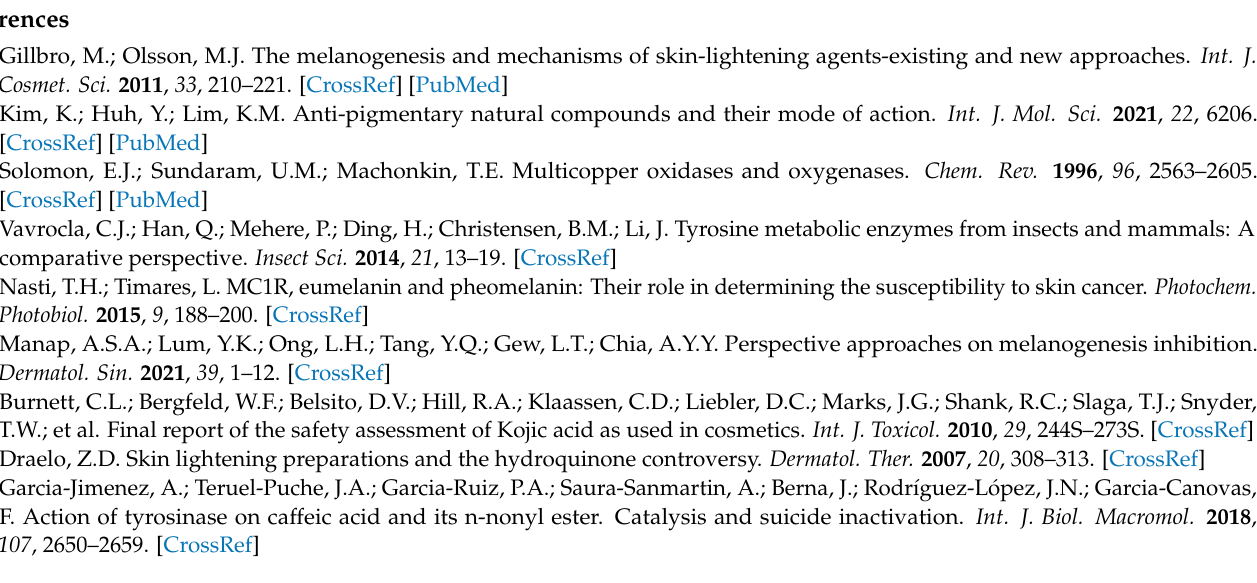
Figure S5: effects on tyrosinase-based biosensors (n = 4) of the exposition in a range comprised between 0 and 150 mM of dopamine, in absence (black line) and in presence (red line) of inhibitor 6. In Panel A, the Michaelis-Menten plots, showing the variations of both VMAX and KM, are reported, while in Panel B the relative Lineweaver–Burk plot is shown (all data are shown in Table 1); Figure S6: effects on tyrosinase-based biosensors (n = 4) of the exposition in a range comprised between 0 and 150 mM of dopamine, in absence (black line) and in presence (red line) of inhibitor 7. In Panel A, the Michaelis-Menten plots, showing the variations of both VMAX and KM, are reported, while in Panel B the relative Lineweaver–Burk plot is shown (all data are shown in Table 1); Figure S7: column graphs describing the effect of different concentrations of compound 1 (panel A), 6 (panel B) and 7 (panel C), ranging from 1 up to 40 µ M, on viability of PC12 cells. p < 0.05 vs. control; Figure S8: representation of the most populated pose of arbutin surrounding the catalytic site with the most representative amino acids residues; Figure S9: representation of the most populated pose of 1 surrounding the catalytic site with the most representative amino acids residues; Figure S10: schematic representation of Tyrosinase-based biosensor used in this study, with tyrosinase reaction mechanism; Figure S11: schematic representation of platinum-based sensor used in this study to investigate the antioxidant proprieties of compound 1, 6 and 7. Pt/Ir: Platinum/Iridium (90:10) wire (1 mm in length; 125 µ m in Ø); PPD: poly-ortho-phenylenediamine polymer; Table S1: docking list of ligands with amino acids of catalytic site of B. megaterium tyrosinase protein (3NM8); Table S2: H-bonds list of ligands with amino acids of catalytic site of B. megaterium tyrosinase protein (3NM8). Author Contributions: Conceptualization, D.F., M.A.D. and G.D.; Data curation, G.R., C.R.,